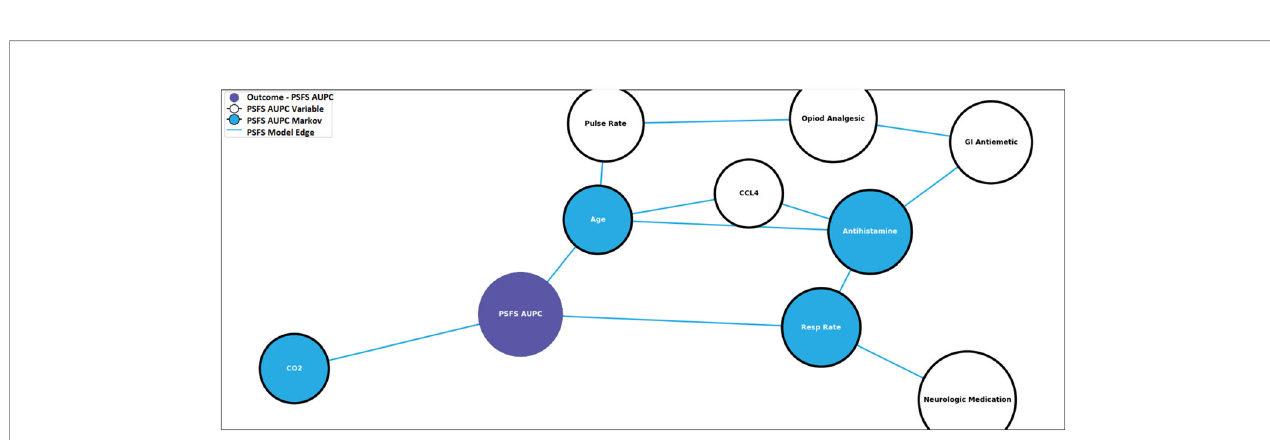
FIGURE 5 | Pre-antivenom prognostic model predictive of recovery. PSFS AUPC: Patient-Speci fi c Functional Scale Area Under the Patient Curve, CCL4: C-C motif ligand 4, GI: gastro-intestinal, CO 2 : carbon dioxide, Resp Rate: respiratory rate.